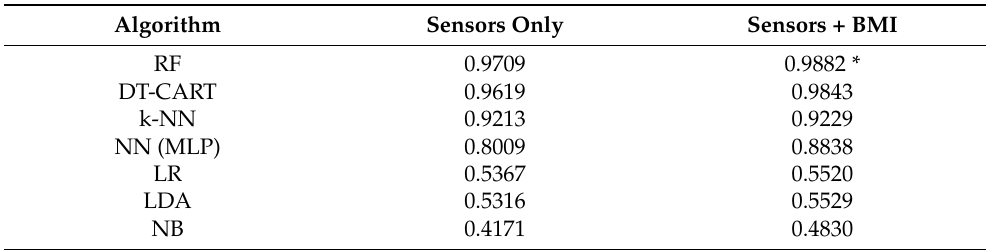
Table 2. Classification performance of the tested algorithms in the sitting posture recognition task. * p < 0.01 Wilcoxon signed rank test.